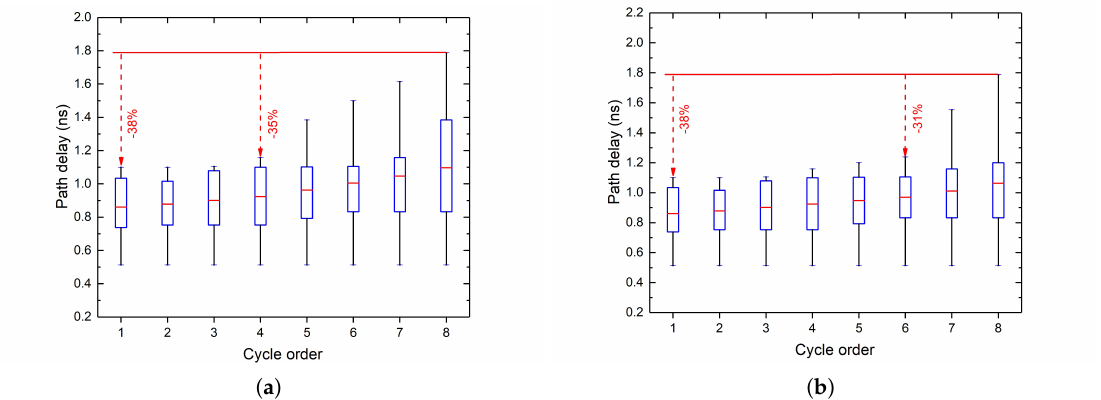
Figure 7. Distribution of path delay in each clock cycle with synthesis optimization, when ( a ) m = 4 ( b ) m =